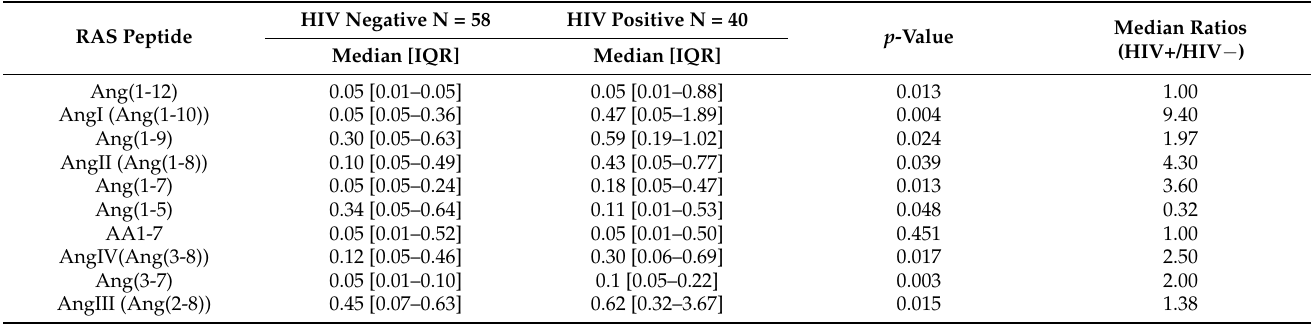
Table 4. Circulating RAS peptides in HIV-negative versus HIV-positive individuals not on antihyper- tensive medications.